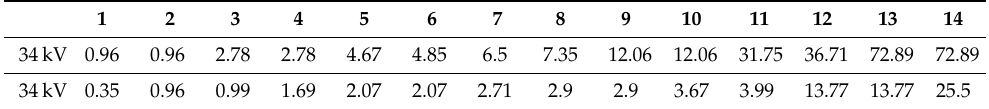
Table 12. SRS for failure times of insulating fluid data when n = 14, m = 14. 1